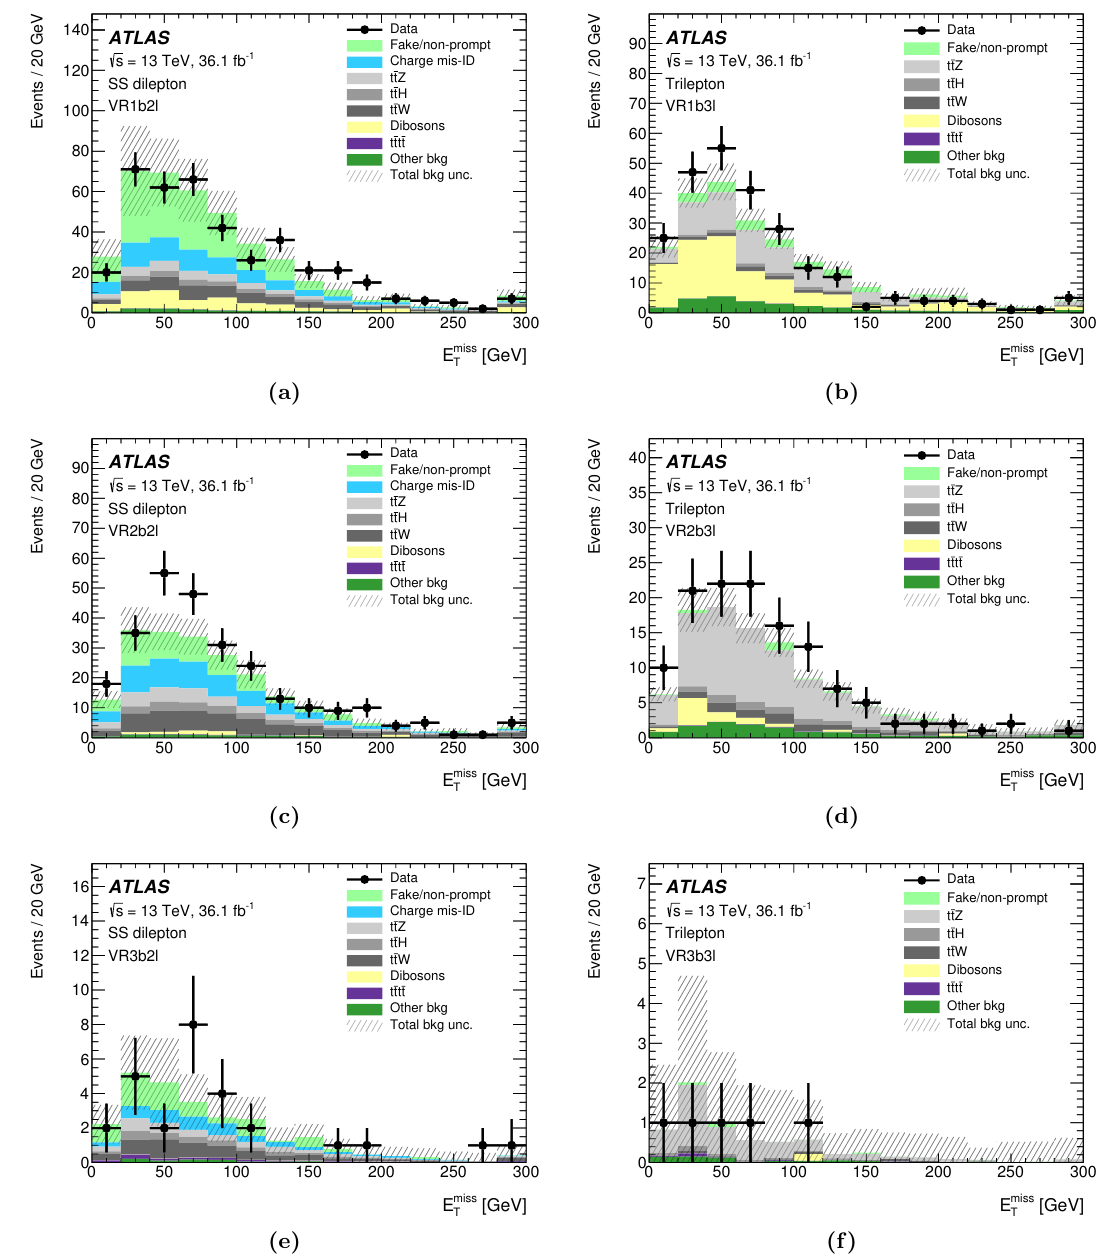
Figure 4 . Distributions of E miss in each of the validation regions used for the four-top-quark and T VLQ searches. The (cid:12)rst (second) column shows distributions of dilepton (trilepton) events while each row corresponds to a given b -tagged jet multiplicity. The uncertainty, shown as the hashed region, includes both the statistical and systematic uncertainties from each background